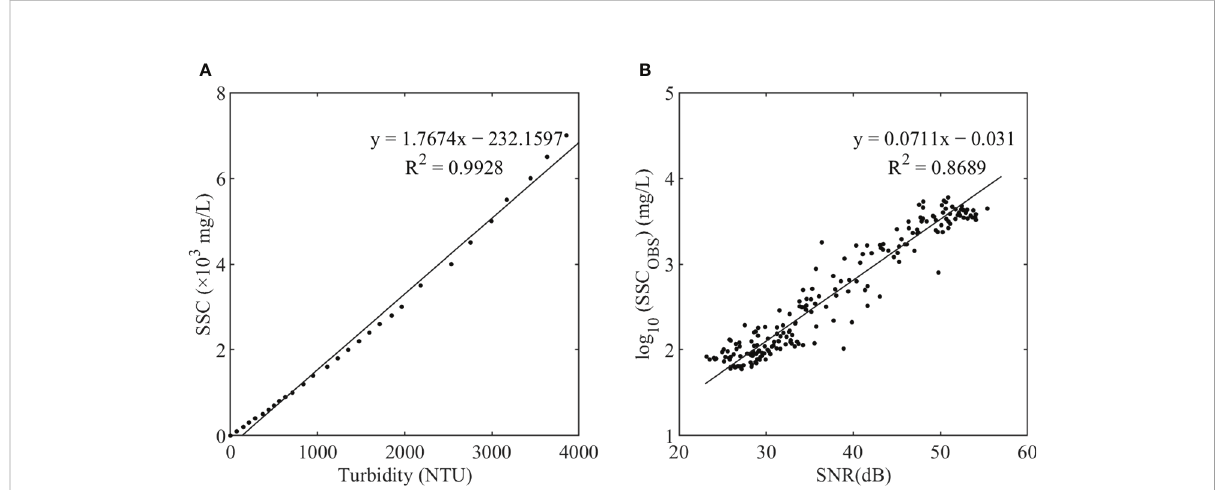
FIGURE 4 Calibration of suspended sediment concentration. (A) Linear regression of optical backscatter sensors (OBS) turbidity and suspended sediment concentration (SSC) in the laboratory. (B) Linear regression of Signal-to-Noise ratio (SNR) recorded via acoustic doppler velocimetry (ADV) and SSC OBS . When establishing the relationship between SNR and SSC OBS , the burst exceeding the OBS range as shown in Figure 7 was